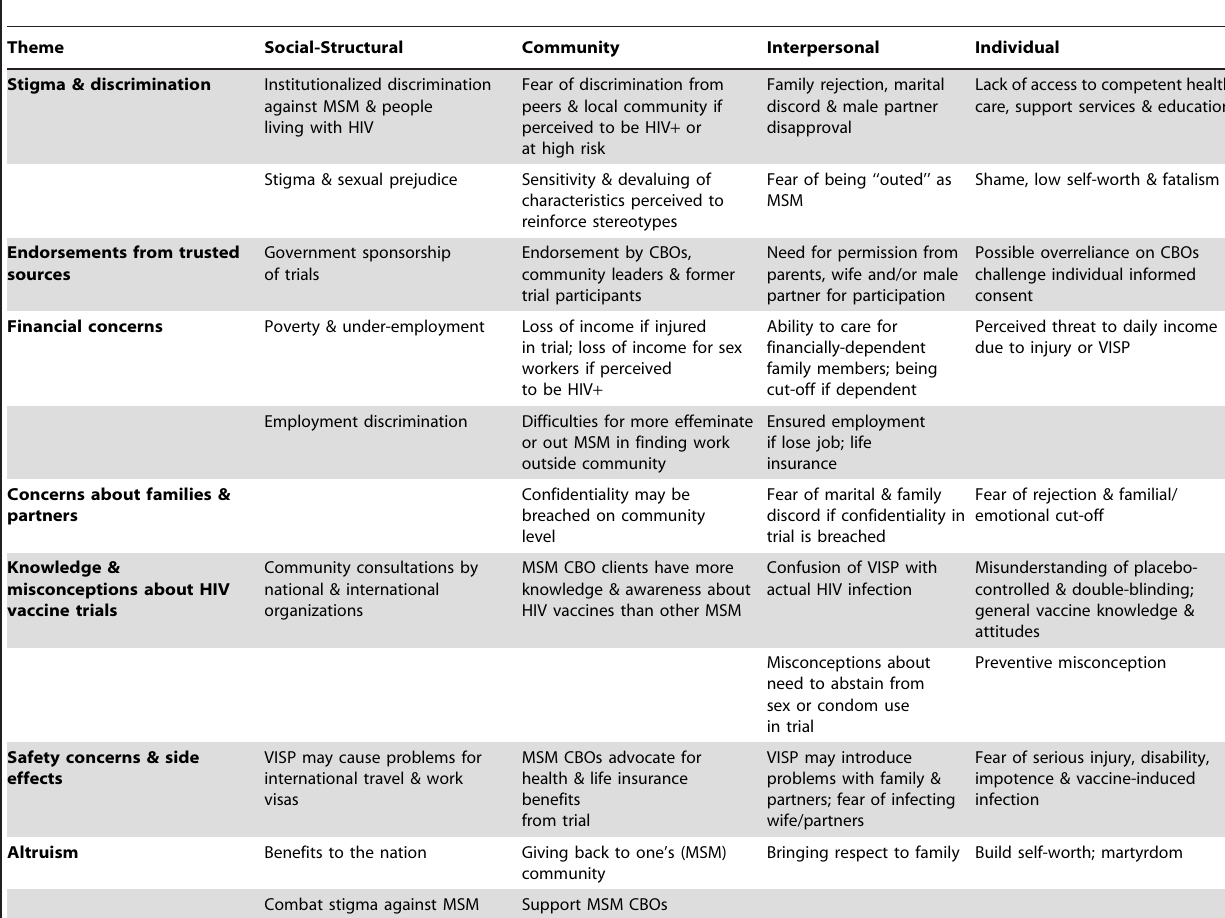
Table 2. Multi-level factors associated with willingness to participate in HIV vaccine trials manifested across the social ecology of MSM in India